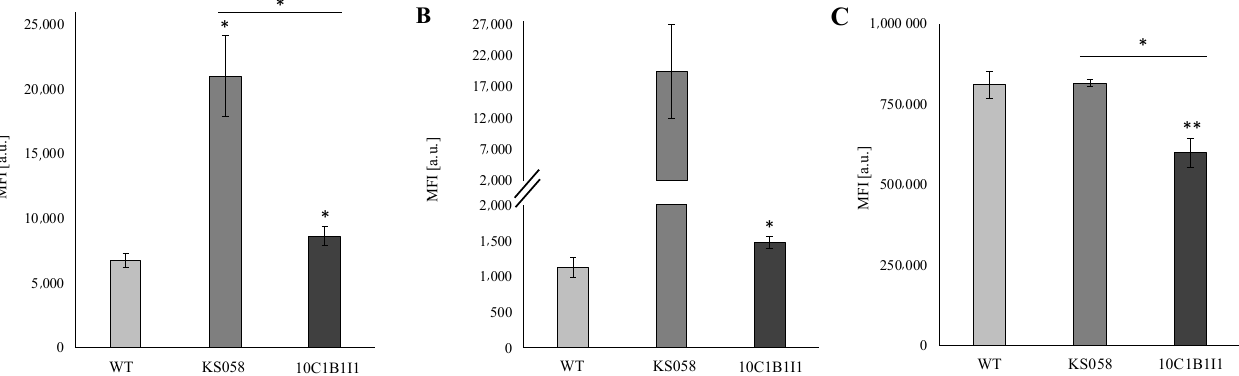
Figure 5. The exposure of chitin (panel ( A )), β -glucan (panel ( B )), and mannans (panel ( C )) in the C. albicans SC5314 wild type (WT), erg11 ∆ / ∆ (KS058) and ERG11 K143R/K143R (10C1B1I1) strains grown for 24 h in YPD (28 ◦ C, 120 rpm). In each case, the C. albicans cells were stained with wheat germ agglutinin conjugated with FITC (WGA-FITC; in case of exposed chitin, panel ( A )), Fc-hDectin-1 and Alexa Fluor 448-conjugated anti-human IgG Fc antibodies (in the case of unmasked β -glucan, panel ( B )) or streptavidin and concanavalin A (ConA) conjugated with Alexa Fluor 568 (in case of mannans, panel ( C )) and analyzed by FACS. Median fluorescence intensities (MFIs) were quantified for three independent experiments. Statistical analyses were performed using the WT strain, or between KS058 and 10C1B1I1 (above lines) (*, p < 0.05 **, p < 0.01).